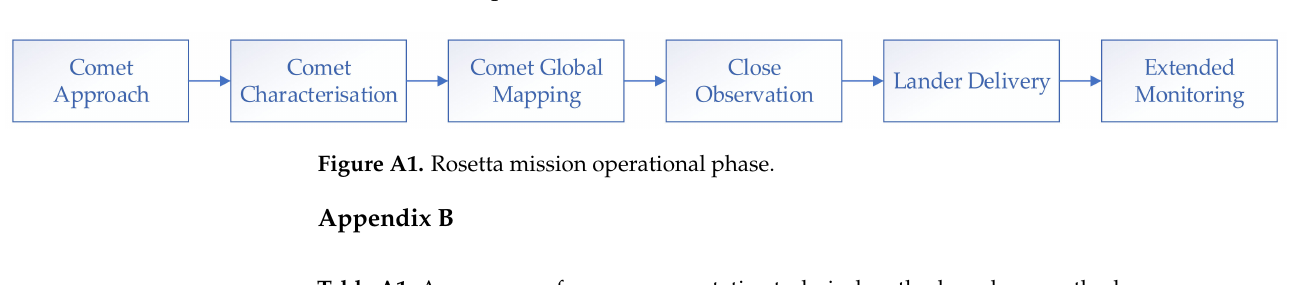
Table A1. A summary of some representative technical methods and our